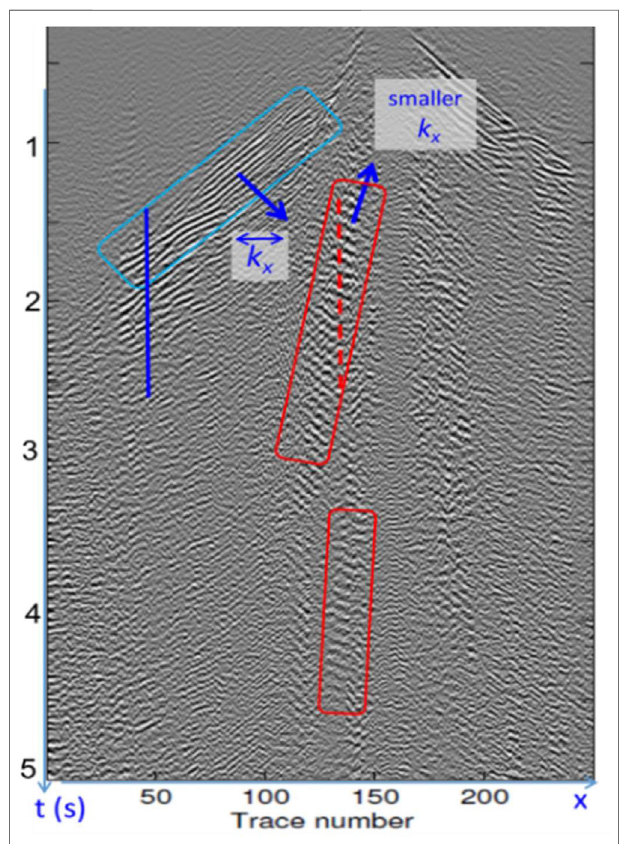
FIGURE 5 | Illustration of the new wavenumber-adaptive bandpass fi lter for seismic traces on the left side of the shot in a common-shot gather. The verticalslicesalongtheblueandredlinesyieldthebandpasspro fi lesin Figure4 . The cut-off frequencies f 1 and f 2 take the same values as in Figure 4